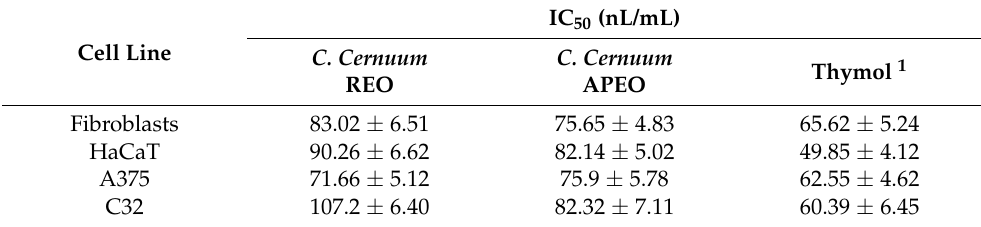
1 1 nL/mL of thymol corresponds to 1 µ